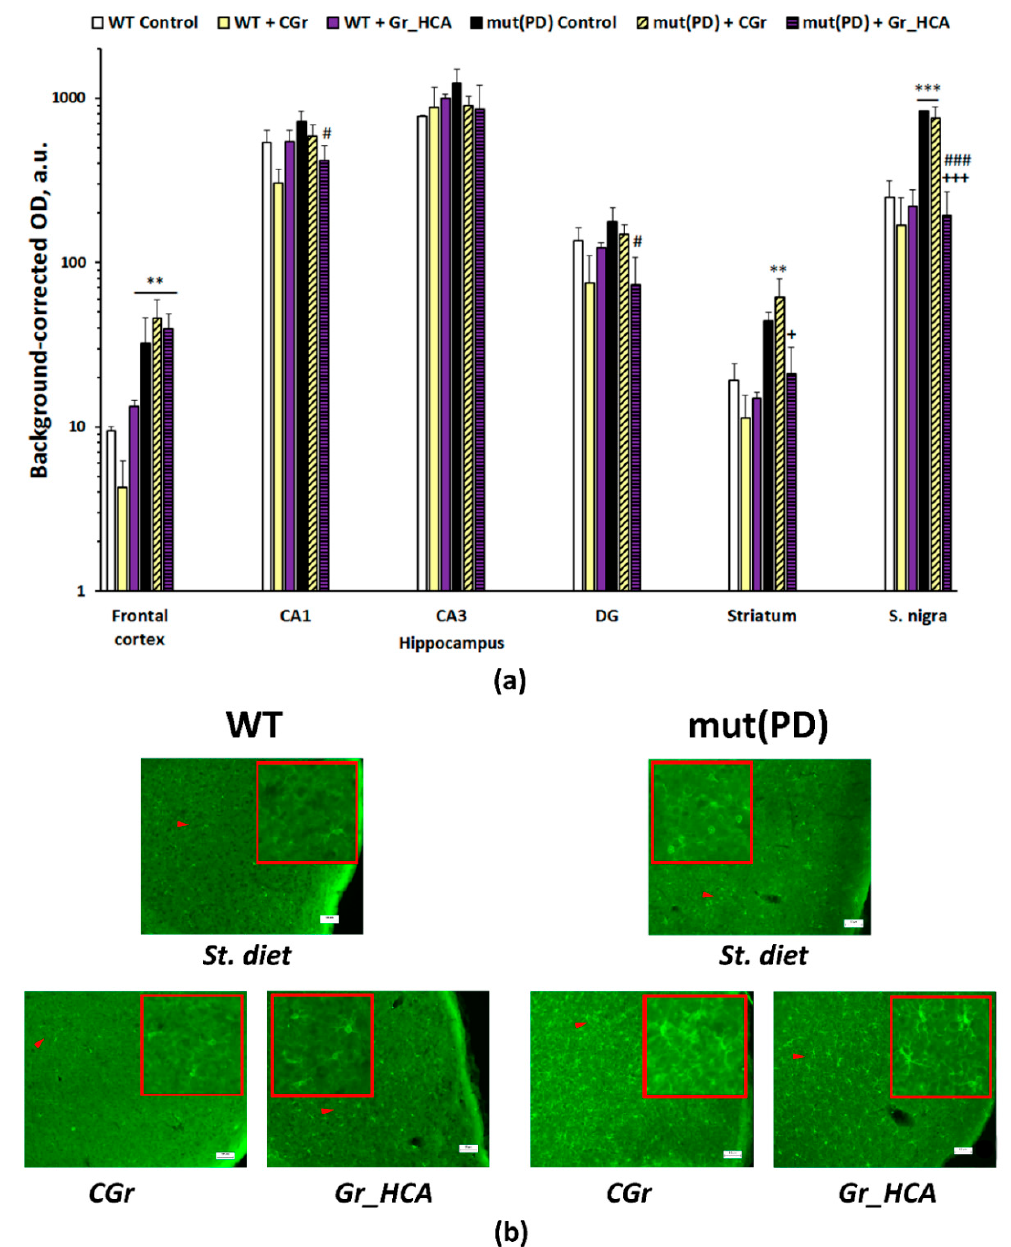
Figure 5. Effects of the type of diet and overexpression of α -synuclein (genetic PD model) on the expression of microglial marker IBA1 in the mouse brain. ( a ) Quantitative results. CA1–CA1 hippocampal area, CA3–CA3 hippocampal area, DG–dentate gyrus. The data are expressed as the means ± SEMs of the values obtained in an independent group of animals ( n = 3–4 per group). Statistically significant differences: ** p < 0.01, *** p < 0.001 vs. respective WT groups; # p < 0.05, ### p < 0.001 vs. a respective group of mut(PD) mice given the standard diet (“mut(PD) + St. diet”); + p < 0.05, +++ p < 0.001 vs. a respective group of mut(PD) mice given the control grain diet (“mut(PD) + CGr”). ( b ) IBA1 immunoreactivity in the frontal cortex. Magnification, 200×; bar, 50 μ m.